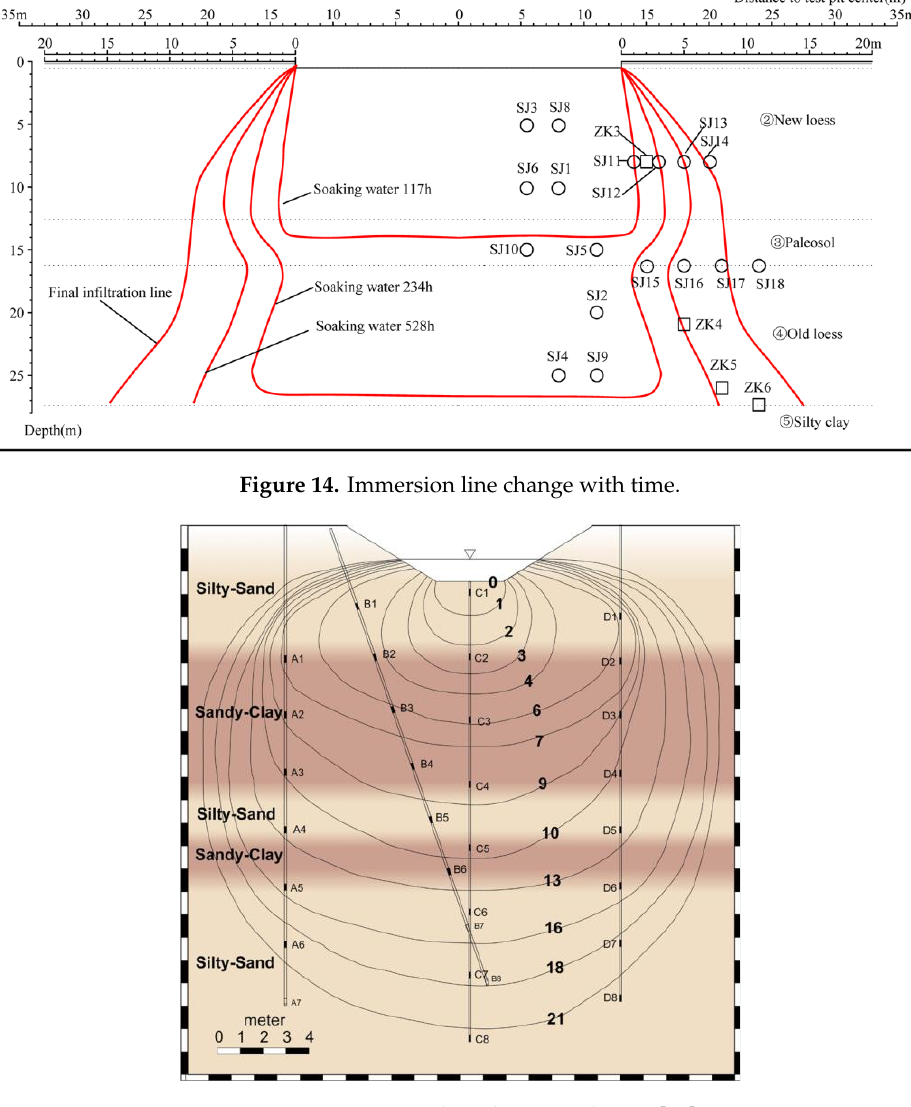
Figure 16. Saturation change, ( a ) saturation change of ZK1, ZK2, ( b ) saturation change of ZK3, ZK4, and ( c ) saturation change of ZK5, ZK6.